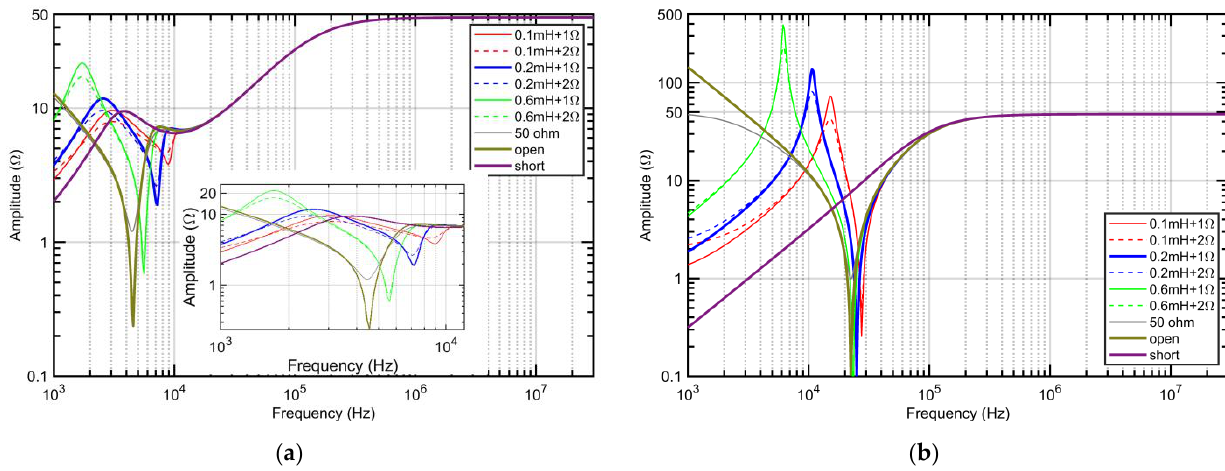
Figure 14. Input impedance of the LISN for different impedances of the power grid attached at the output port: ( a ) CISPR16; ( b ) CISPR22 LISN.